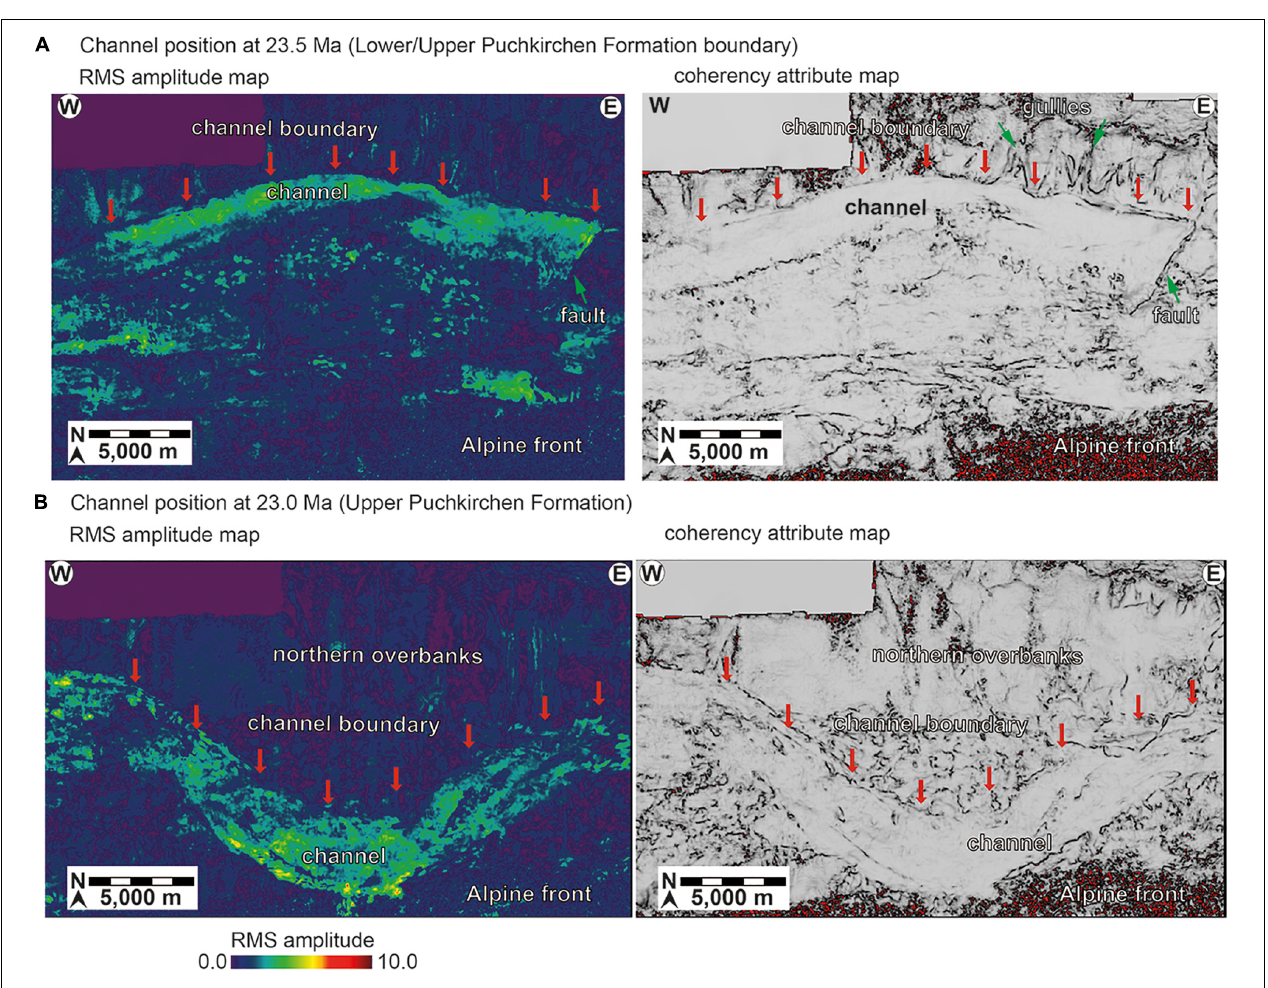
FIGURE 13 | RMS amplitude and coherency maps of the channel and overbank area (for position see Figure 1B ) at 23.5 Ma (A) and 23.0 Ma (B) . At 23.5 Ma (A) the channel is close to the northern border of the seismic cube, the overbanks are narrow. Until 23.0 Ma (B) the channel changes its position close to the Alpine thrust front and creates wide, northern overbanks. Red arrows mark the channel boundary, green arrows the gullies on the NSU and a